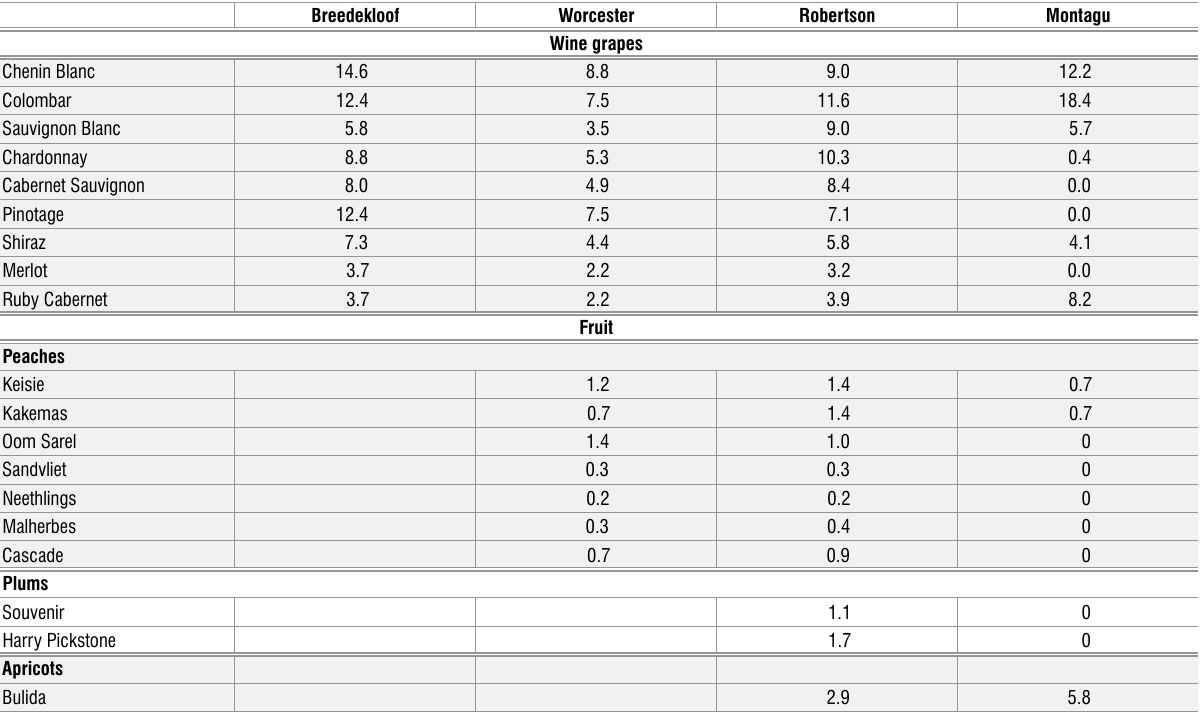
table 2: Land-use system (ha) for the ‘typical farm’ for each relatively homogeneous area Breedekloof worcester robertson montagu